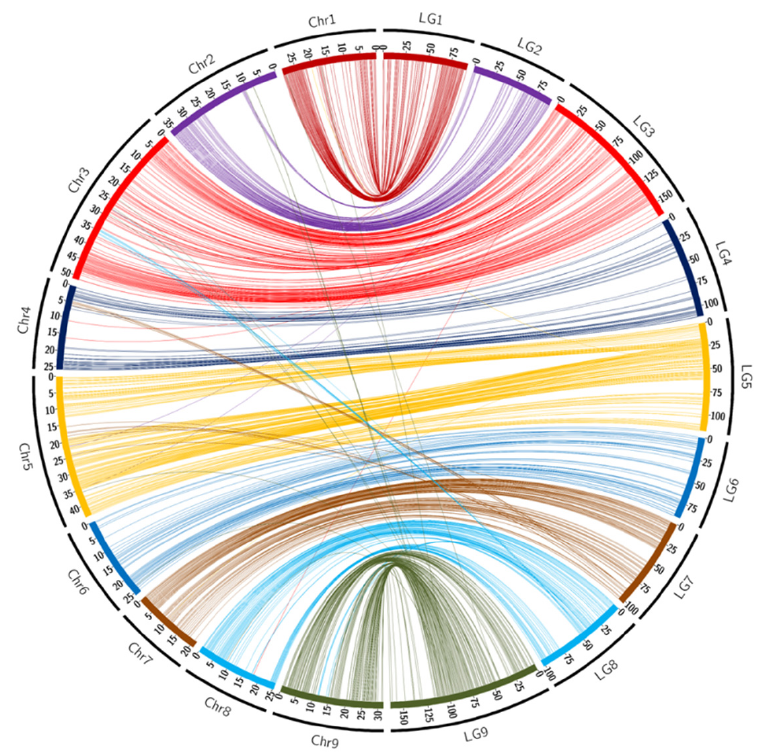
Figure 2. Links between the position of markers on the ‘Ellendale’ genetic map (LGs) and on the chromosome assembly (Chr) of the clementine genome [65]. Scales are in cM for LGs and in Mb for chromosomes.